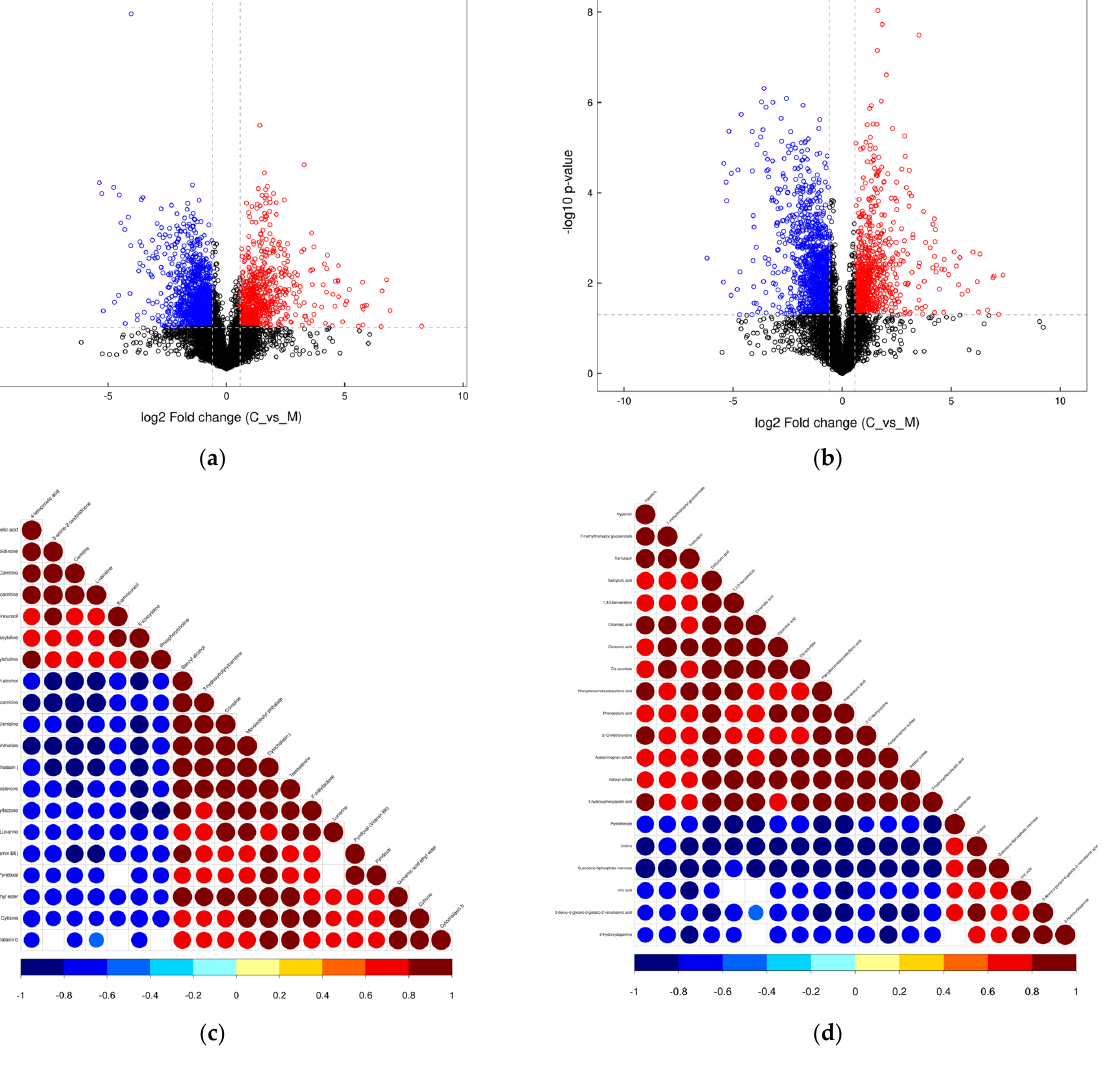
Figure 6. ( a ) Volcano plot of the metabolites abundance in yak colostrum by contrast with mature milk in positive ionization mode. The abscissa represents the value of log 2 FC, and the ordinate represents the value of − log 10 p . A point represents a metabolites molecule. The points with FC > 1.5 and p < 0.05 are shown with red; the points with FC < 0.67 and p < 0.05 are shown with blue; non- di ff erential metabolites (DMs) are shown with black. ( b ) Volcano plot of the metabolites abundance in yak colostrum by contrast with mature milk in negative ionization mode. ( c ) Correlation heat map of the top 20 DMs in positive ionization mode. Red indicates the positive correlation; blue in- dicates the negative correlation; white indicates the non-signi fi cant correlation. The color depth was related to the absolute value of correlation coe ffi cient. The higher the positive or negative correlation was, the darker the color was. The dot size was related to the correlation signi fi cance. The more signi fi cant the correlation was, the larger the dot was. ( d ) Correlation heat map of the top 20 DMs in negative ionization mode.